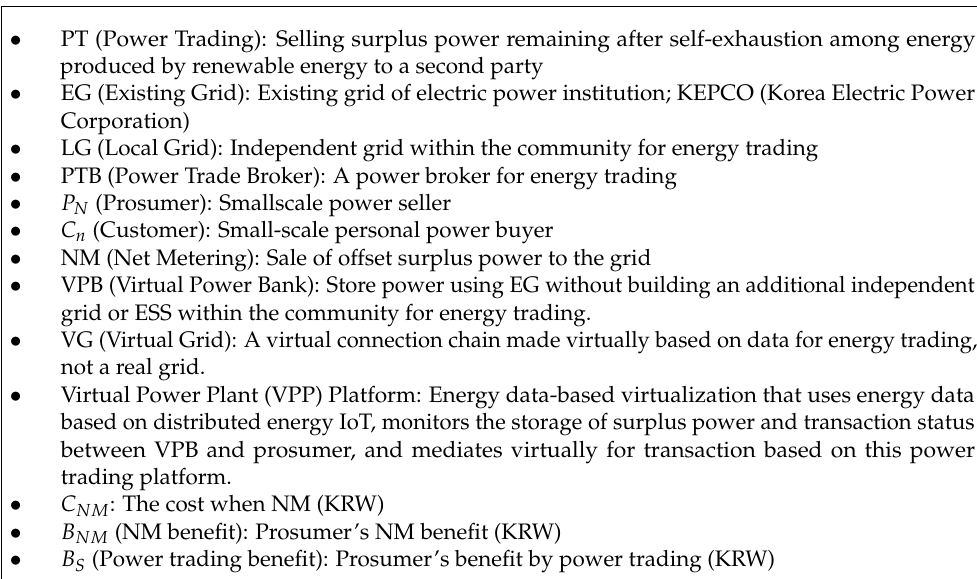
Figure 2. Schematic diagram of a typical energy trading system. Box 3.